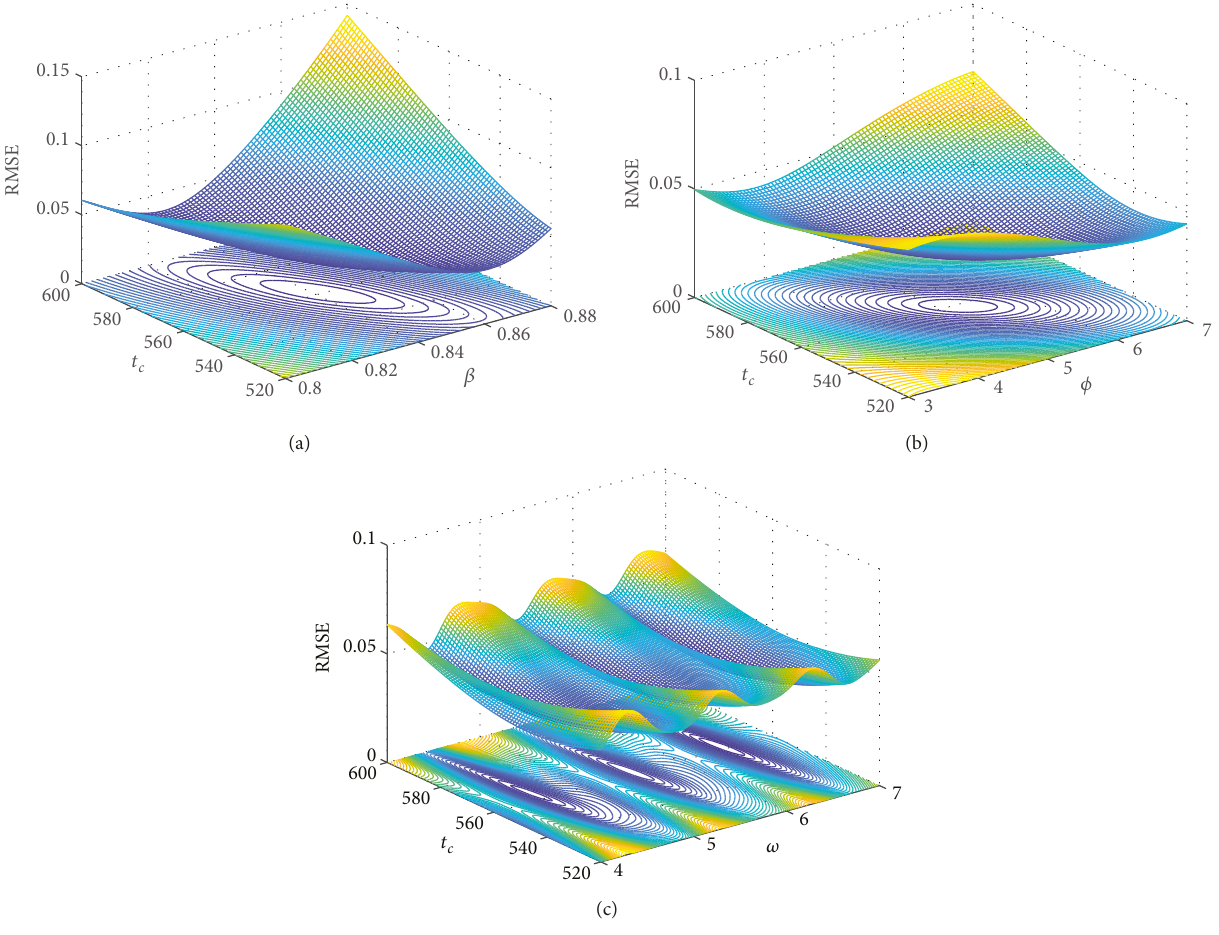
Figure 2: Sensitivity analysis of the RMSE to LPPL parameters